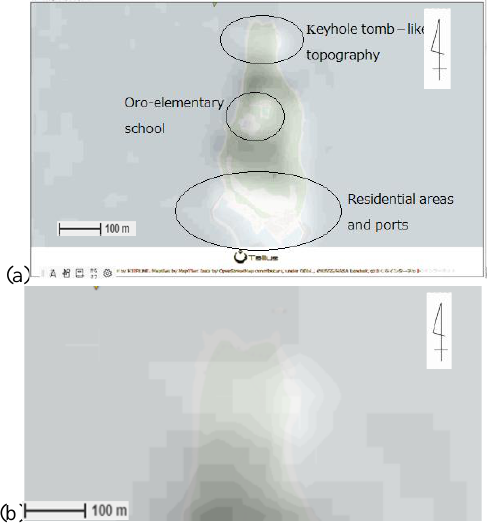
Fig.9 composite image of far infrared image and orono-shima island map.(*Note that the resolution is 100m)